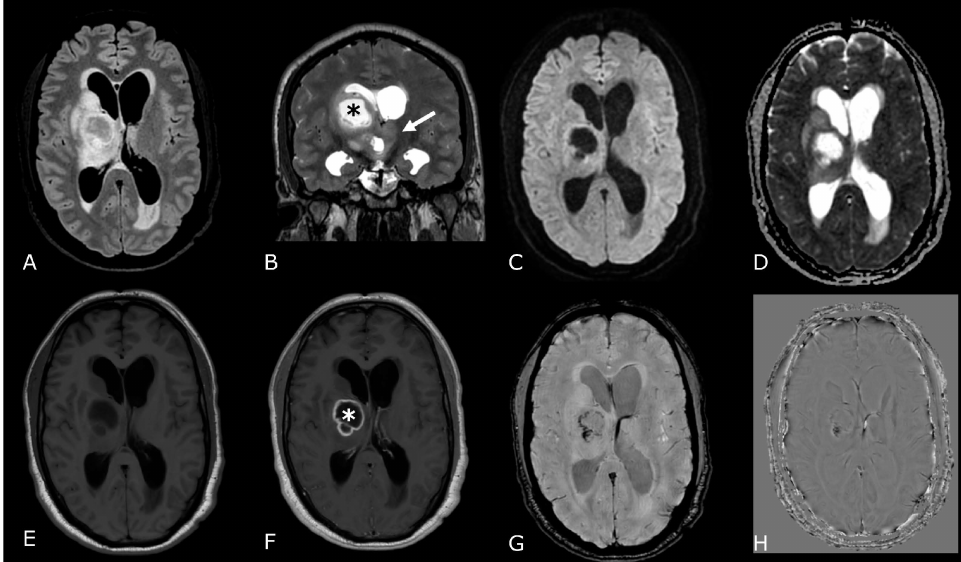
Figure 2. Conventional MR sequences: necrosis and hemorrhages. Right deep thalamo-capsular IDH-wt GB. The lesion shows a necrotic core (asterisk in ( B , F )) and a thick and irregular rim of hypercellular tissue with restricted diffusion ( C , D ) and contrast-enhancement (( F ) compared to ( E )). ( G , H ) demonstrate hemosiderin marginal deposits (hypointense on both SWI and phase-map respectively) suggestive of intratumoral bleedings. The “rim enhancing” lesion is surrounded by a peripheral heterogeneous area of abnormal T2w/FLAIR signal ( A , B ), reflecting infiltrative “non enhancing” tumor and vasogenic edema that also involves the mesial surface of the contralateral thalamus and hypothalamus (arrow in ( B ). The caudal extension determines stenosis of the Sylvian aqueduct and consequently supratentorial hydrocephalus.